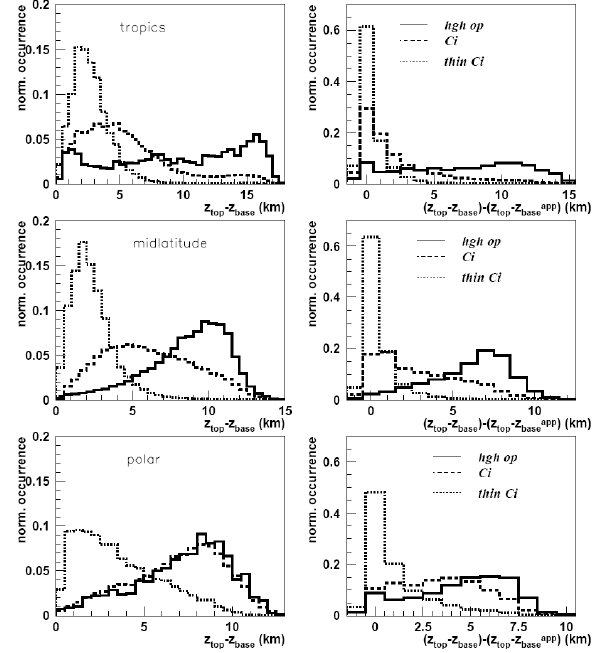
Figure 10: Normalized frequency distributions of the geometrical cloud thickness (left panel), separately for high opaque clouds (full line), cirrus (broken line) and thin cirrus (dotted line), obtained from Radar-Lidar GEOPROF data, and of the difference between geometrical cloud thickness from Radar-Lidar GEOPROF data and the one obtained from CALIPSO (right panel). Distributions are presented for three different latitude bands: 30°N-30°S (upper panels), 30°-60° (middle panels) and 60°-90° (lower panels).